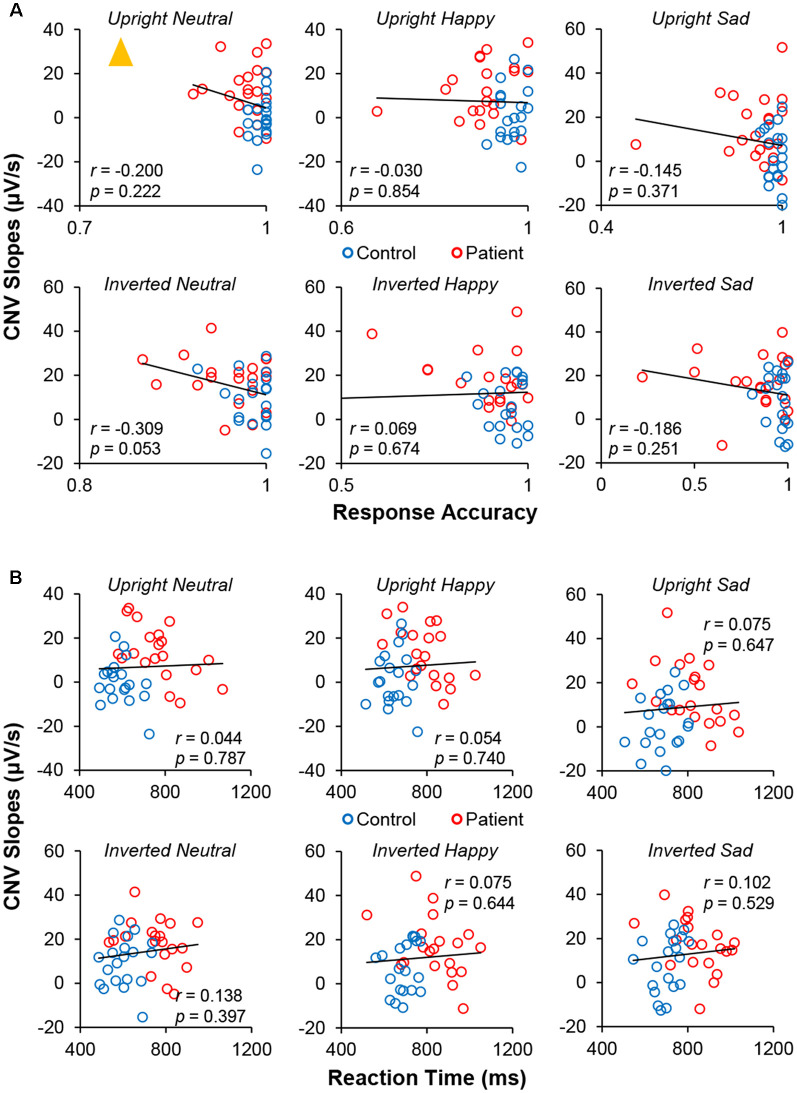
Pearson correlation measurements between CNV slopes and (A) response accuracy and (B) RT under six conditions. The yellow triangle represents the outlier point.